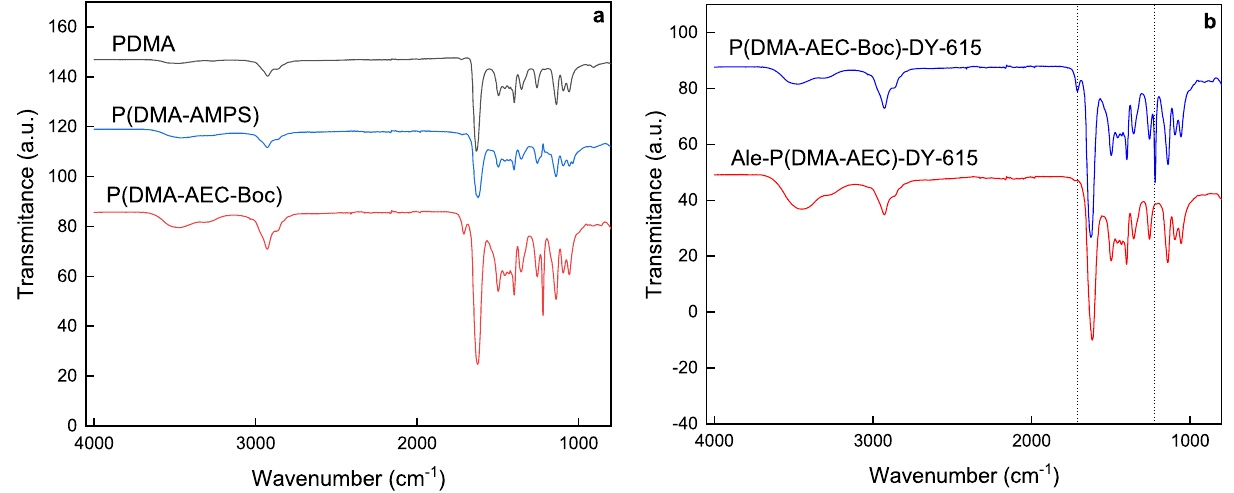
Figure 2. ATR FTIR spectra of ( a ) PDMA, P(DMA-AMPS), P(DMA-AEC-Boc) and ( b ) Ale-P(DMA- AEC)-DY-615 after deprotection of amino